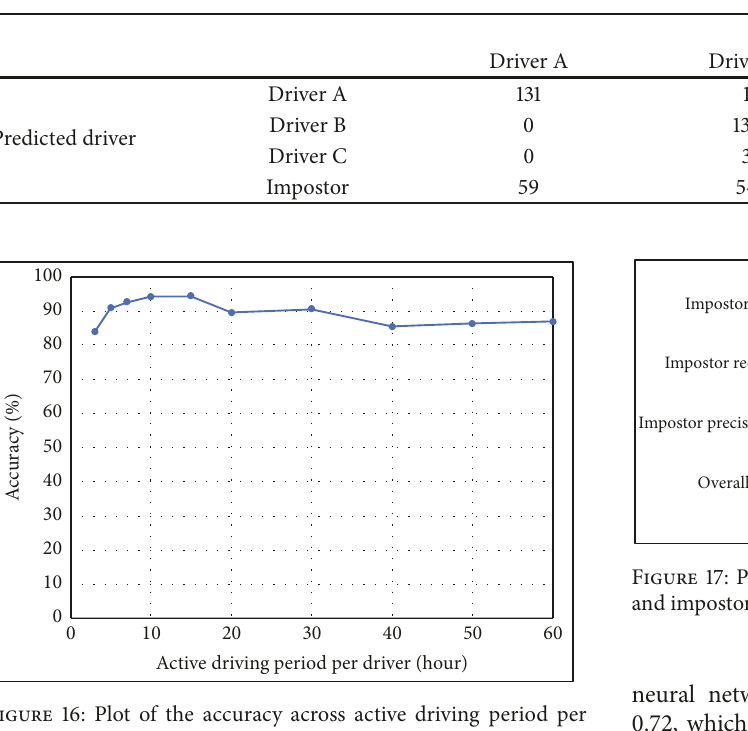
Table 3: Summation of the confusion matrix from 10-fold cross validation in the impostor detection experiment when utilizing the neural network.